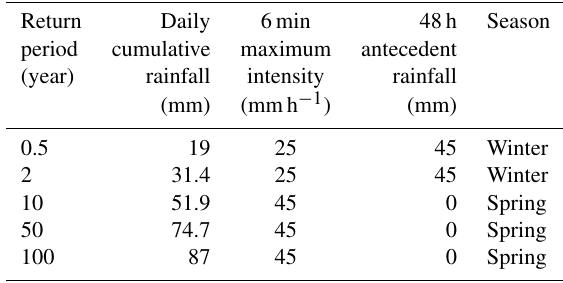
Table 1. Design storms defined for the Radicatel catchment and considered for the